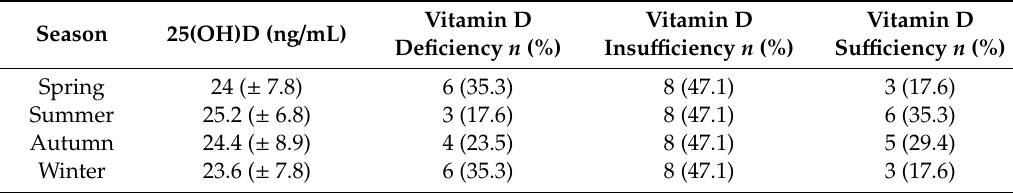
Table 8. Seasonal variation of serum 25(OH)D levels and prevalence of deficiency, insu ffi ciency, and su ffi ciency in patients with heart